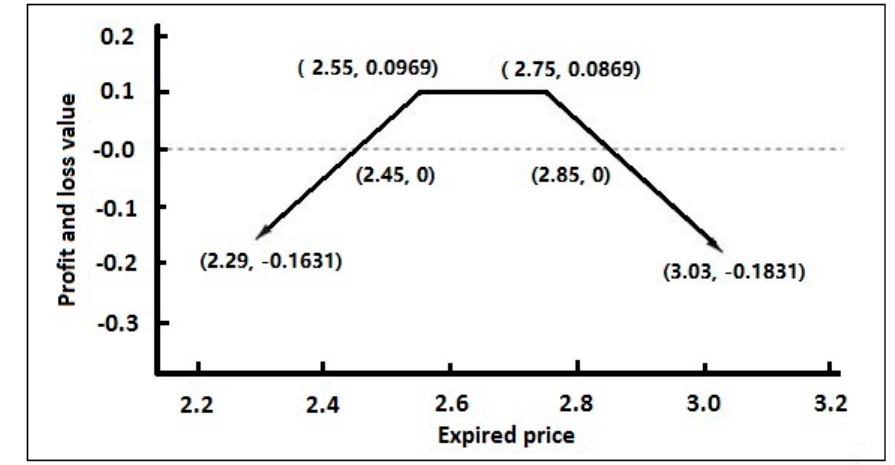
Figure 6. Short strangle options profit and loss chart.